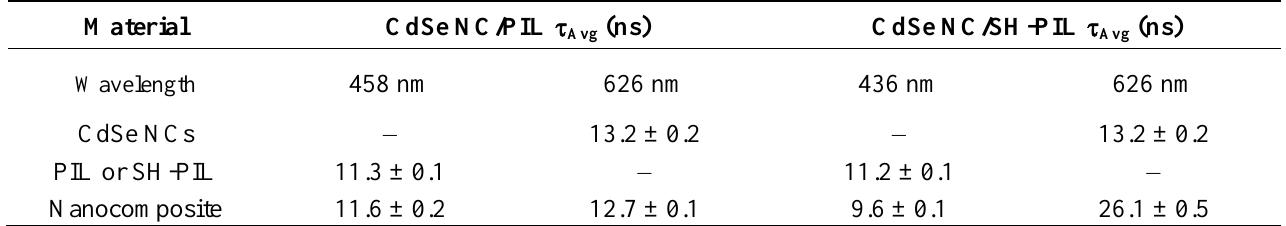
Table 1. Average decay times (τ ), calculated according to Jones and Scholes, by using Avg lifetimes (τ ) and amplitudes ( A ) obtained by a three-exponential fitting. Average lifetimes i i refer to the CdSe NCs, PIL and SH-PIL DMSO dispersion and their corresponding nanocomposite dispersions, measuring decays at the PIL PL peak (458 nm), at the SH-PIL peak (436 nm) and at the CdSe NC peak (626 nm)